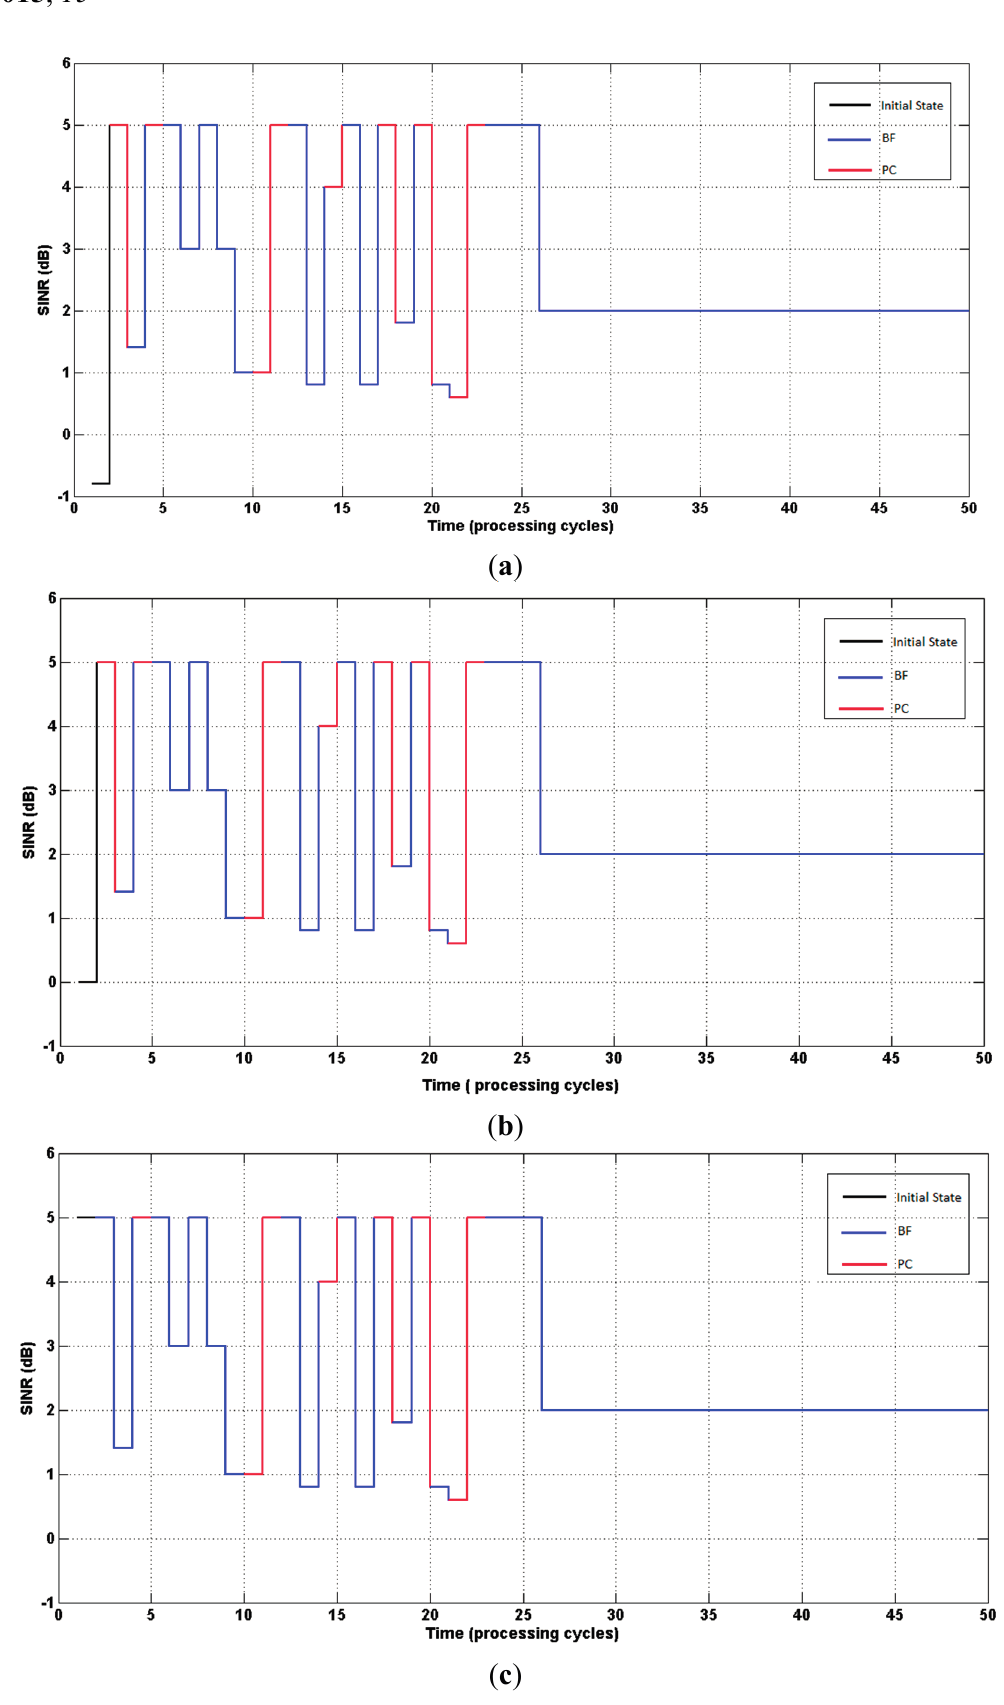
Figure 3. ( a ) System response. Agent started with SINR = − 0.8 dB; ( b ) System response. Agent started with SINR = 0 dB; ( c ) System response. Agent started with SINR = 5